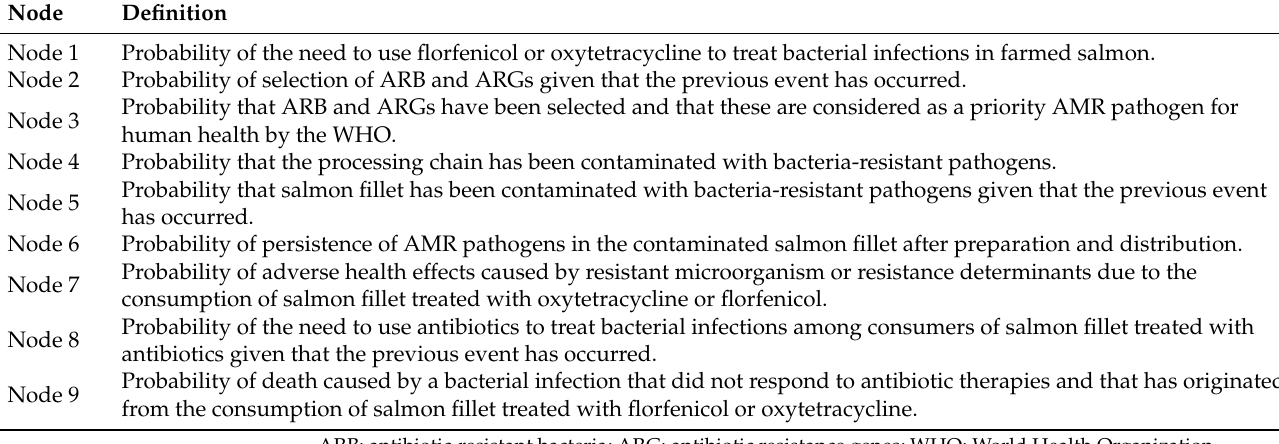
Table 3. Definition of nodes that could result in ARB and/or ARGs acquisition by humans through consumption of farmed salmon that has been treated with florfenicol or oxytetracycline during the salmon production